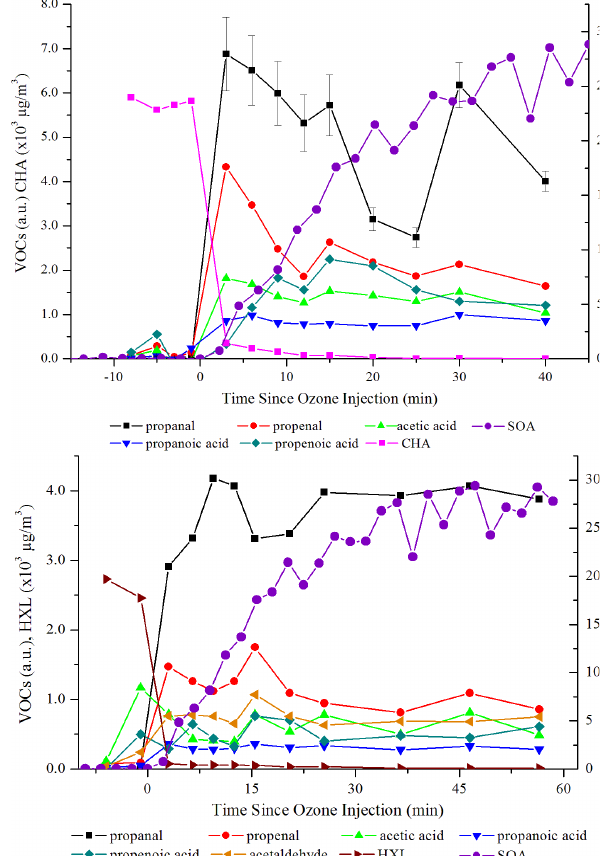
pressures of these species (1 × 10 − 7 atm and 2 × 10 − 5 atm,